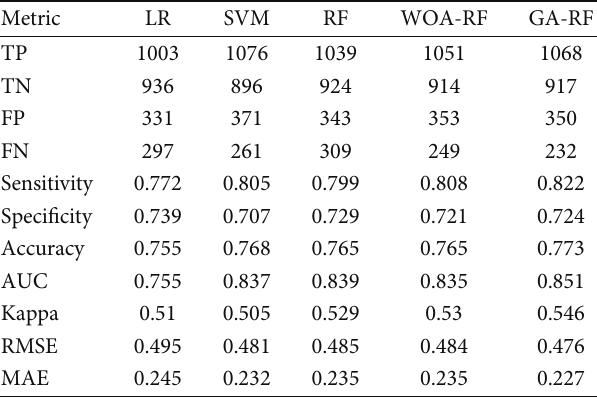
Table 6: Model performance on the test dataset. Metric